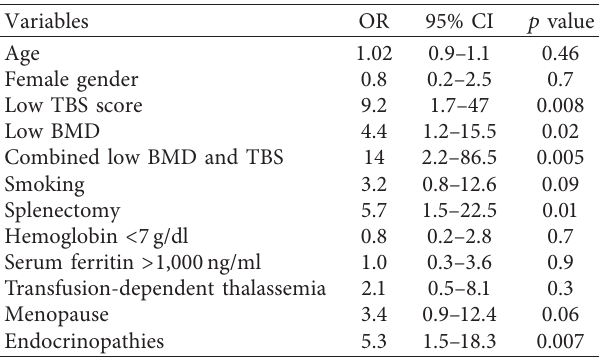
Table 2: Univariate analysis of risk factors for vertebral fractures.